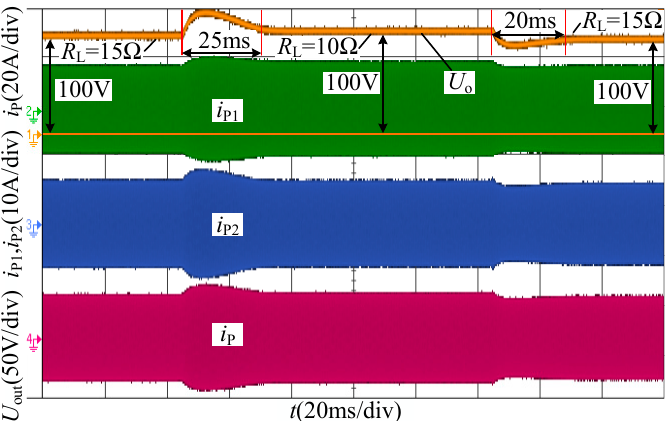
Figure 14. Close loop system response to step change of load resistance from 15 Ω to 10 Ω and then back to 15 Ω .